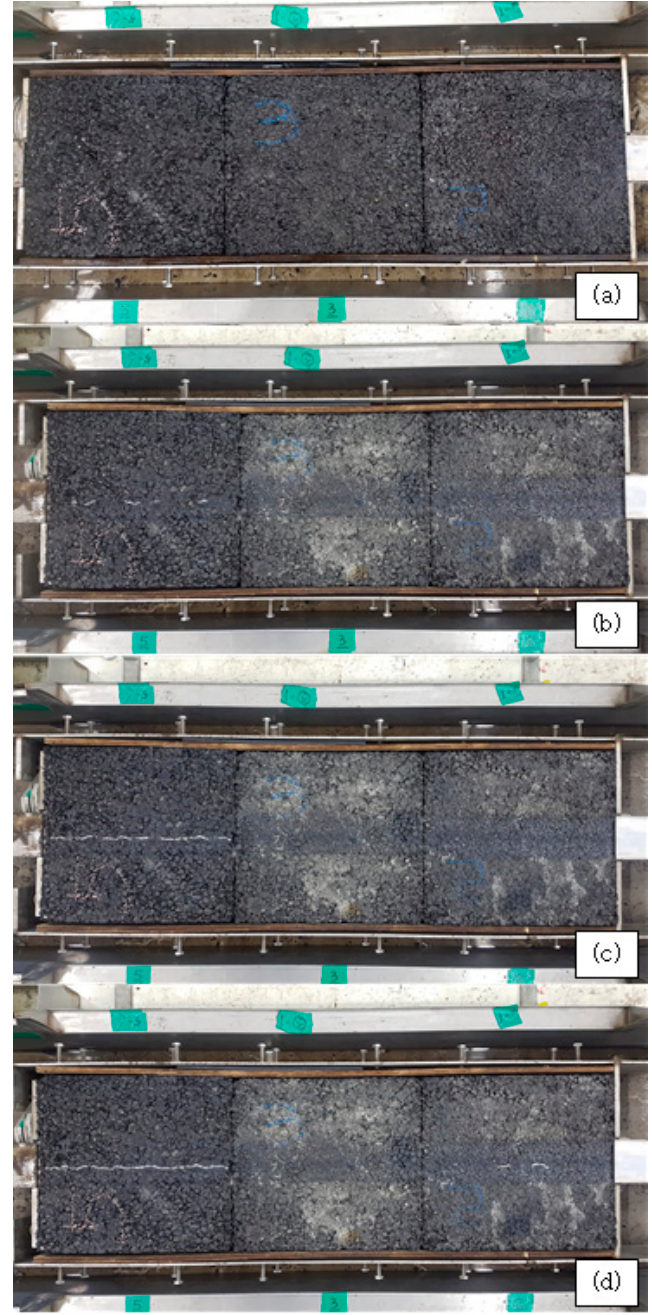
Figure 4. Reflective crack occurrence and propagation. ( a ) specimen top view before the MMLS3 load is applied; ( b ) small cracks that occurred on the surface of specimen on the left side; ( c ) specimen on the left side, reflective cracks have occurred entirely on the surface; ( d ) the cracks occurred gradually in the specimen on the right side.